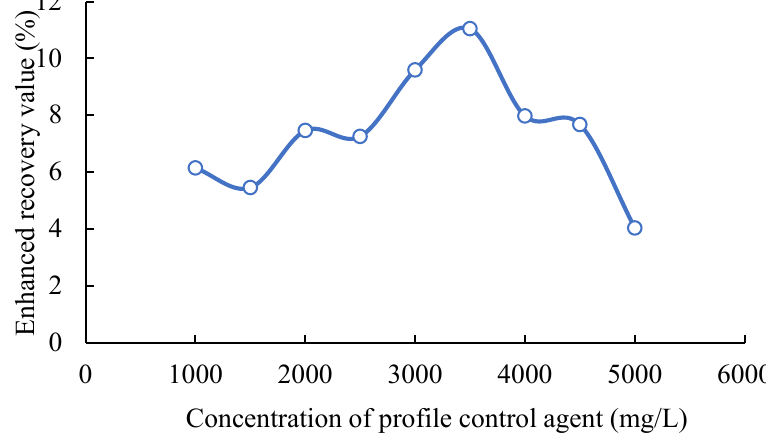
Figure 6. Injection concentration-percent recovery rate curve. Distilled water with different PV numbers was injected into the core after the asphalt profile control agent was injected, and the numerical changes of the injection pressure and calculated permeability at each stage were monitored as shown in Figure 7.